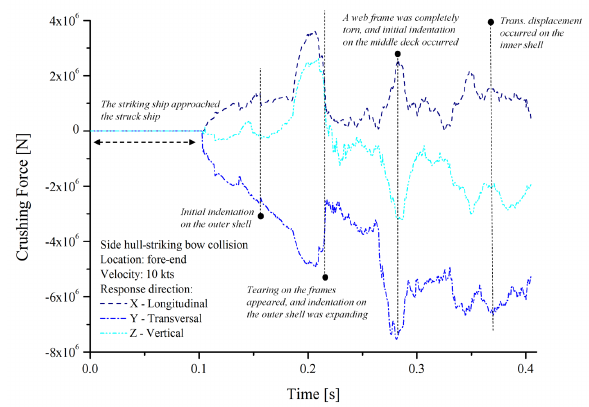
Figure 12: Structural responses of the struck ship – fore-end against collision with velocity 10 kts.